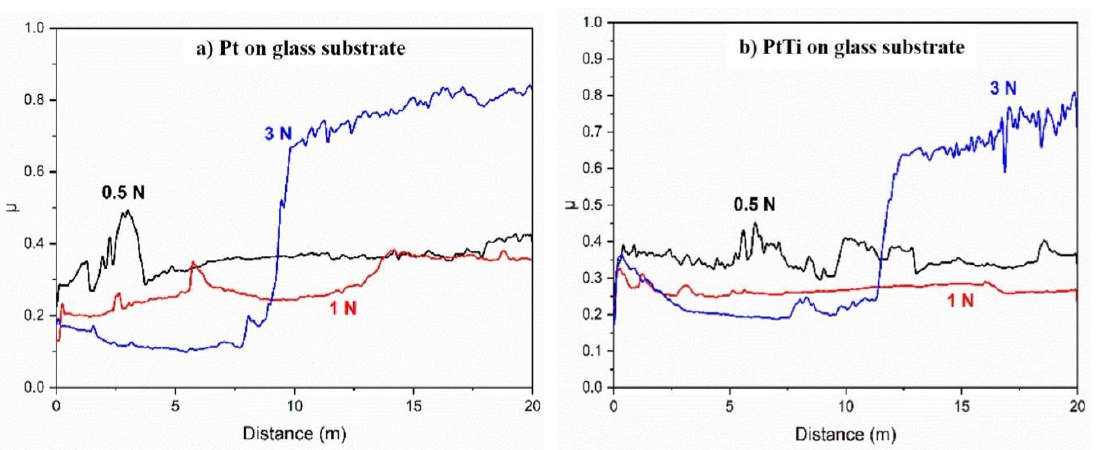
Figure 4. Overlapped graphs of friction coefficient as a function of the distance at an applied force of 0.5 N, 1 N, and 3 N, for ( a ) Pt on a glass substrate and ( b ) PtTi on a glass substrate.